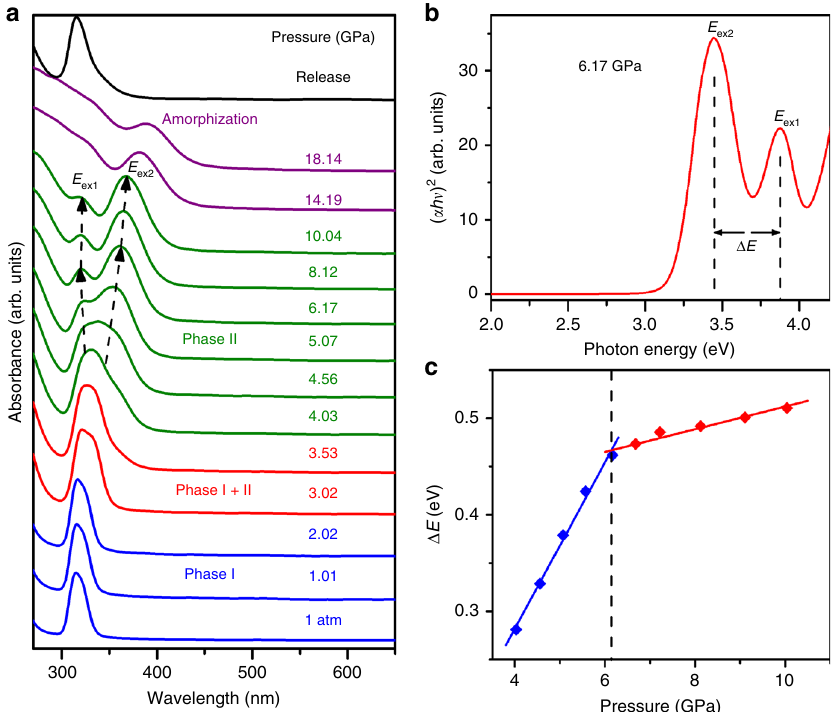
Fig. 3 Optical absorption of Cs 4 PbBr 6 NCs with increasing pressure. a Typical pro fi le of the absorption band for Cs 4 PbBr 6 NCs at different pressures measured in situ in a DAC apparatus. The dashed arrows indicate the shift of the bound exciton absorption peaks of E ex1 and E ex2 . b Absorption spectra of Cs 4 PbBr 6 NCs measured at a selected pressure of 6.17 GPa. E ex1 and E ex2 represent the splitting bound exciton absorption peaks. c Pressure dependence of energy difference Δ E deduced from the difference of E ex1 and E